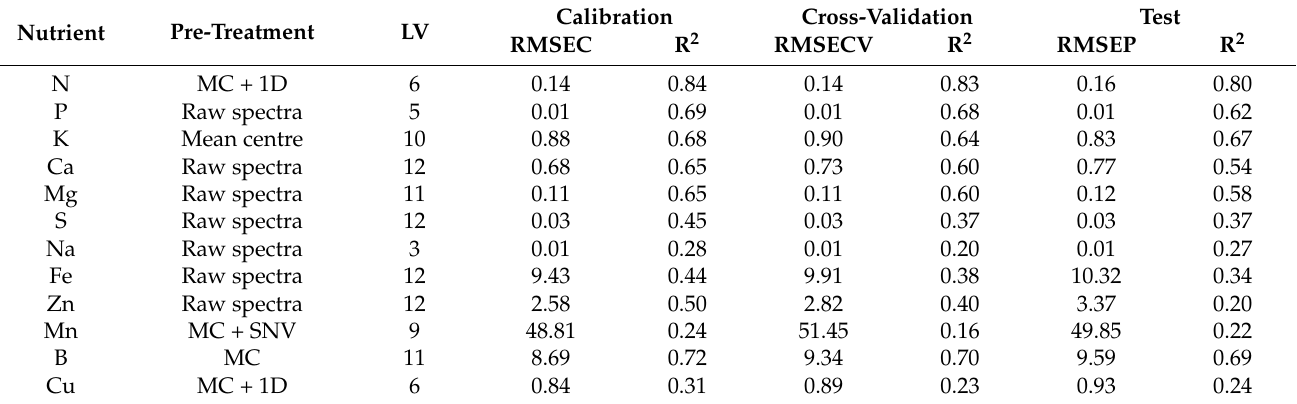
Table 3. Comparative statistics for the calibration, cross-validation and test sets of the model gener- ated by PLS-R for essential nutrients using all